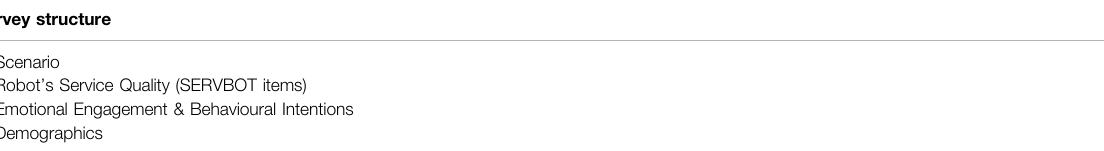
TABLE 1 | Respondent ’ s pro fi le.